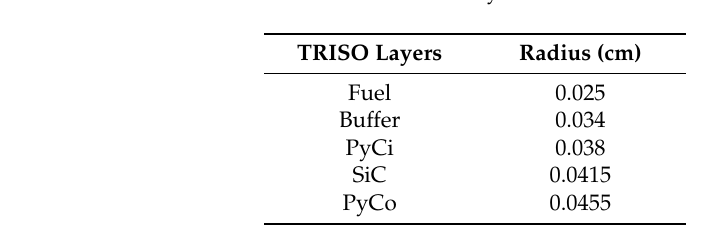
Table A2. TRISO layers dimensions.